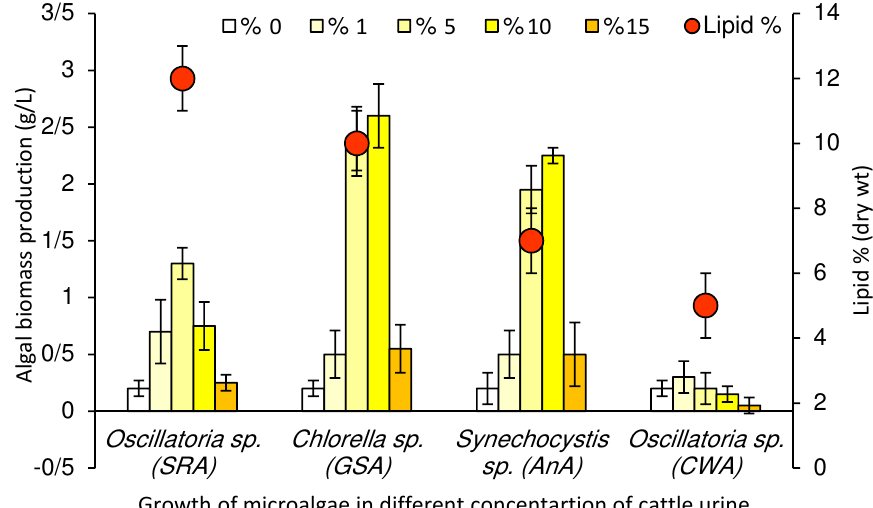
Fig. 3: Biomass production and maximum lipid percentage of microalgal isolates cultured in cattle urine at varied dilutions Table 2: Comparison of microalgae biomass production using urine as nutrient source Microalgae Urine concentration (v/v) Biomass production Reference Chlorella sp.,